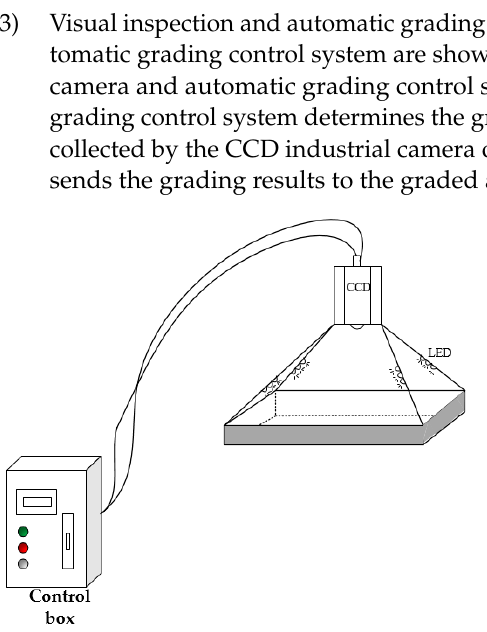
Figure 4. Visual inspection and automatic grading control system structure diagram.